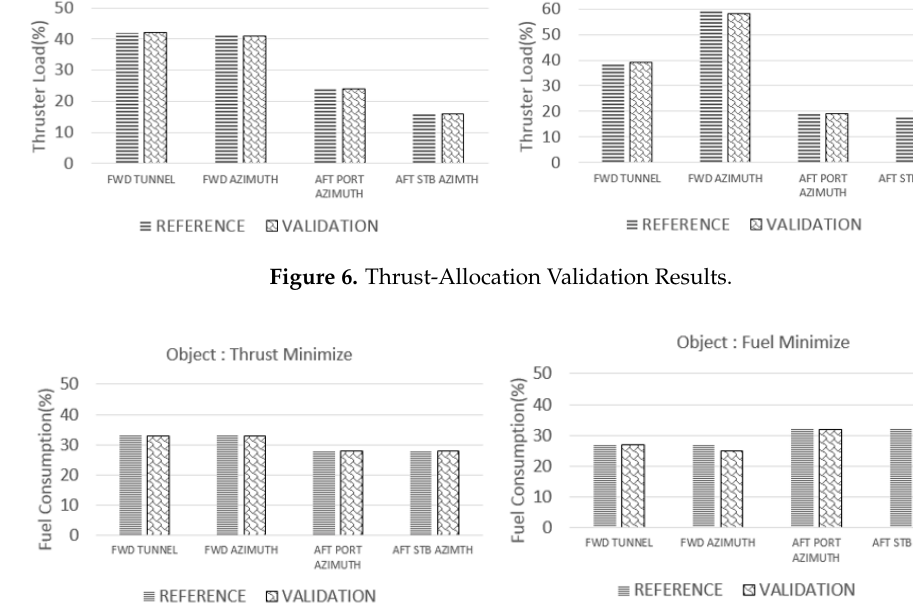
Figure 7. Fuel-Consumption Validation Results.